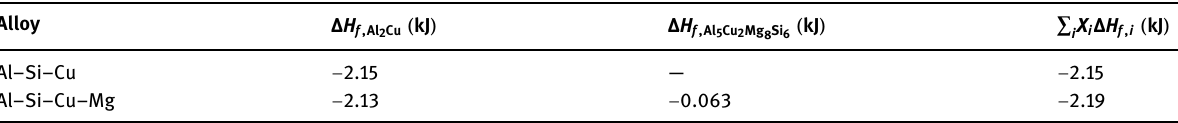
Table 6: Enthalpy of the formation of compound phases in 1 mol eutectic alloy Alloy